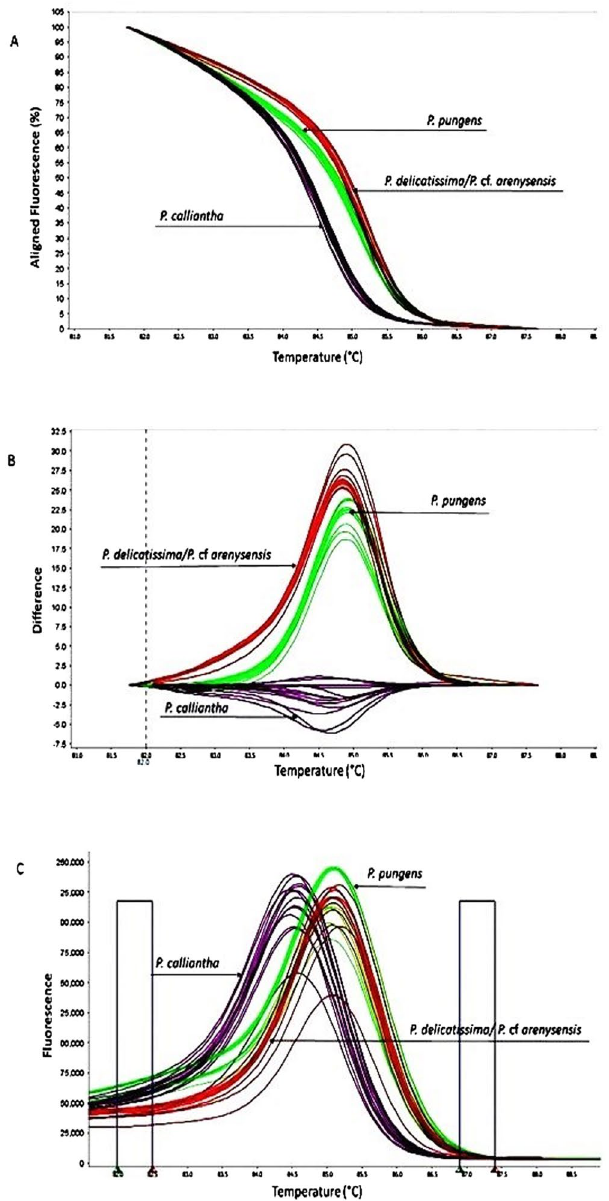
Figure 2. Melting curve variance of the P. calliantha (n = 12 strains), P. delicatissima/P . cf. arenysensis (n = 10 strains) and P. pungens (n = 7 strains) in (A) aligned, (B ) difference and (C ) derivative plot analyses; from left to right, vertical bars represent the pre and post – melt regions. A melting curve generated by a DNA positive control for each taxon was also included. Only one replicate of the HRM assay experiment for each strain is